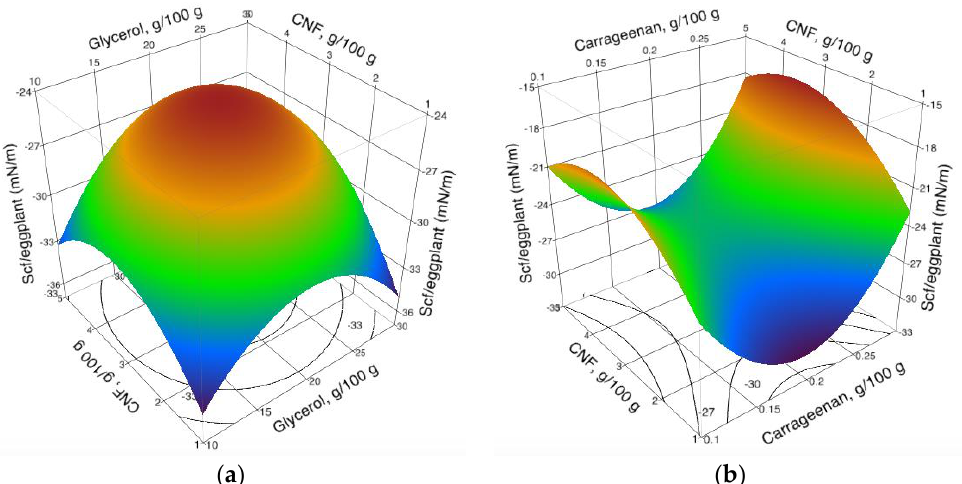
Figure 3. Response surface of S cf/eggplant as a function of ( a ) cellulose nanofibers (CNF) and glycerol, ( b ) κ-carrageenan and cellulose nanofibers (CNF).